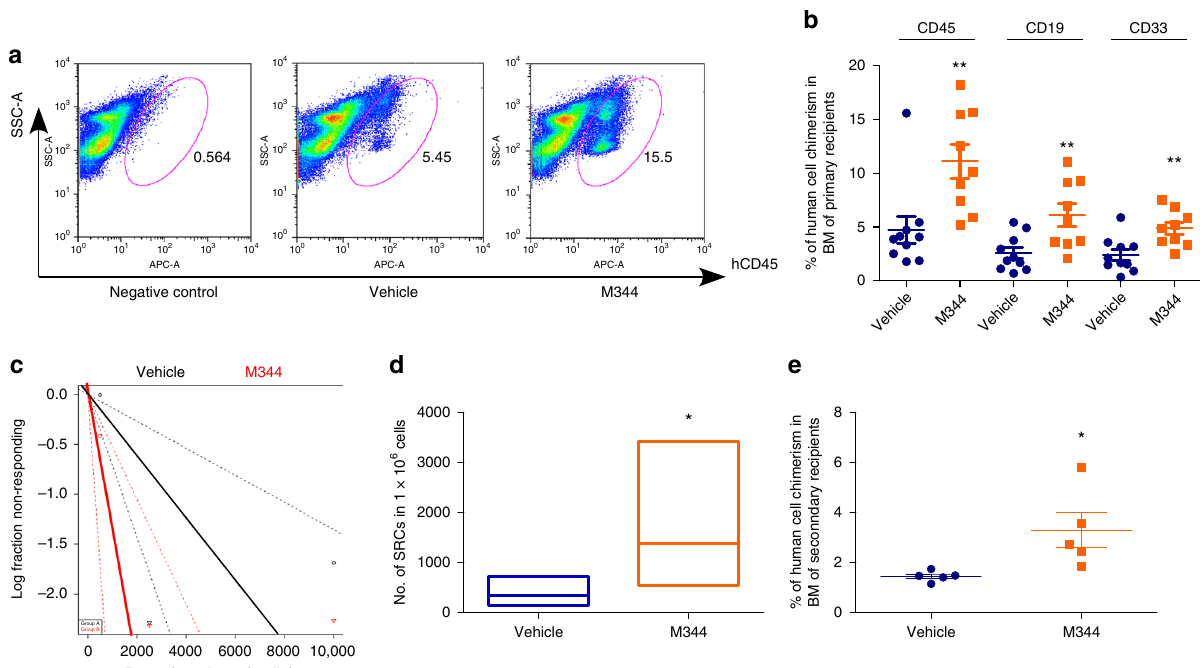
Fig. 2 Inhibition of HDAC promotes long-term engraftment of human CB HSC. a Representative fl ow cytometric analysis of human engraftment in the BM of NSG mice, 16 weeks after transplantation. Left is from a mouse without transplantation (negative control), center and right are from mice transplanted with human CB CD34 + cells treated with vehicle control or M344 for 16 h. Human engraftment was assessed as the percentage of human CD45 + cells. b The percentage of human CD45 + cells, B-cell (CD19 + ), and myeloid cell (CD33 + ) chimerism in the BM of NSG mice after transplantation with 10,000 CB CD34 + cells that had been treated with vehicle or M344. The data were pooled from two independent experiments ( n = 10 mice for vehicle group, n = 9 for M344 group, t -test, ** p < 0.01). c , d The frequency of human SRCs in CB CD34 + cells treated with vehicle control or M344. c Poisson statistical analysis of data from Supplementary Table 1. n = 30 mice in total. Shapes represent the percentage of negative mice for each dose of cells. Solid lines indicate the best- fi t linear model for each data set. Dotted lines represent 95% con fi dence intervals. d HSC frequencies (line in the box) and 95% con fi dence intervals (box) presented as the number of SRCs in 1 × 10 6 CD34 + cells. Poisson statistical analysis, * p < 0.05. e Human CD45 + cell chimerism in the BM of secondary recipient NSG mice at 16 weeks, which had been transplanted with 5 × 10 6 BM cells from primary recipient NSG mice ( n = 5 mice per group, t -test, * p < 0.05). For all panels, data are shown as dot plots (mean ±